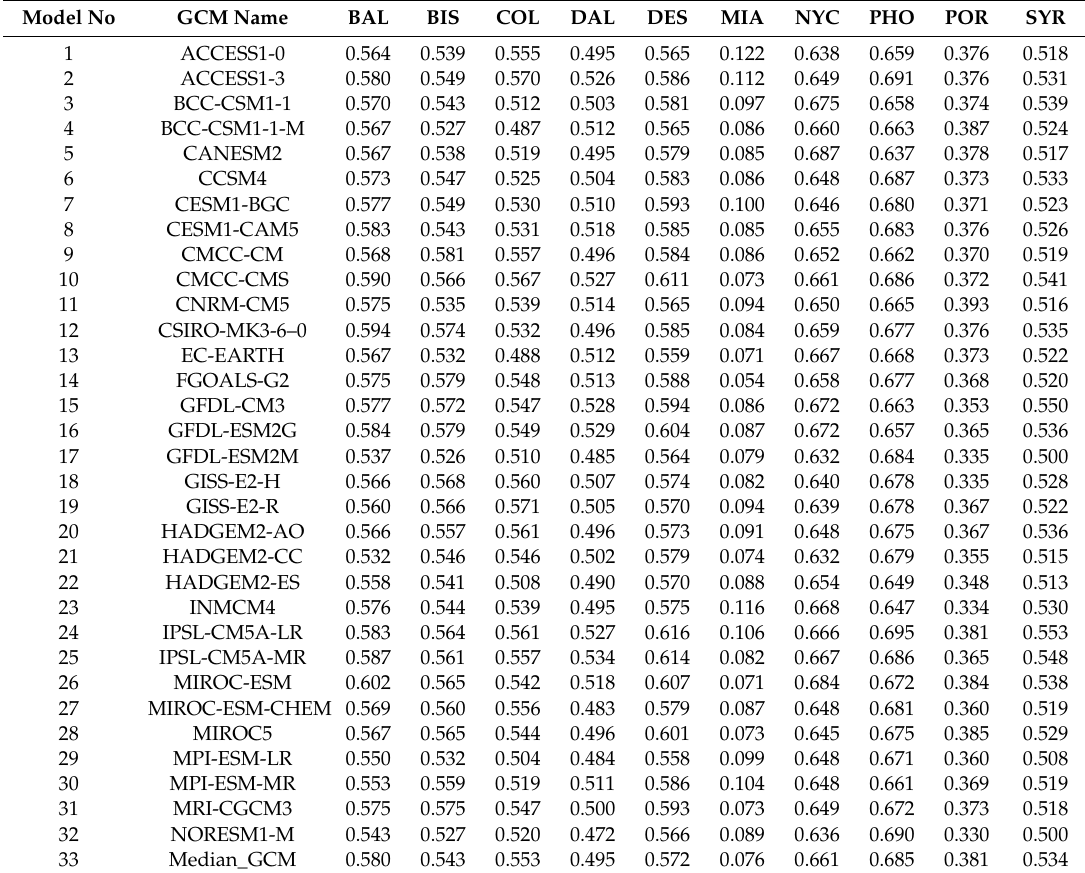
Table A4. NSE coe ffi cient of minimum temperature between observed and simulated data (1950–2005). Model No